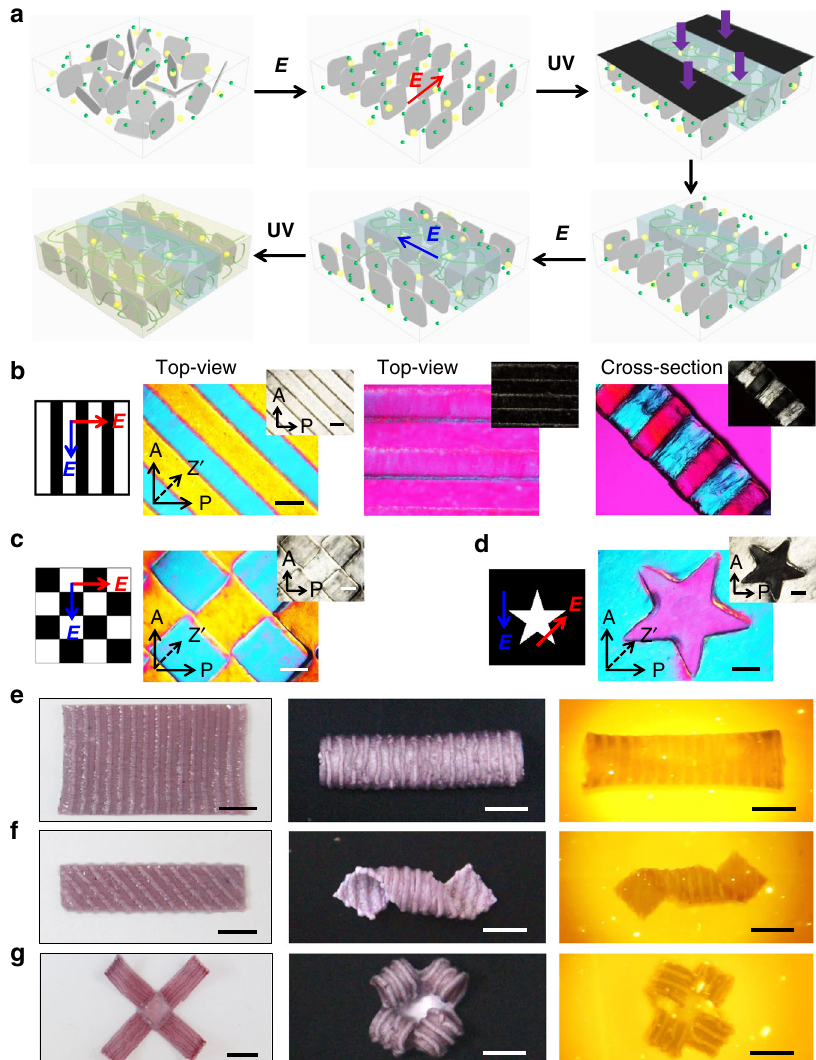
Fig. 3 Multi-step fabrication and programmed deformation of patterned anisotropic hydrogels. a – d Schematic for the preparation of patterned anisotropic hydrogel containing AuNPs by multi-step electrical orientation and photolithographic polymerization ( a ) and POM images of representative hydrogels patterned with different masks and alignment of NSs ( b – d ). Scale bar, 1 mm. e – g Photos of patterned anisotropic hydrogels before (the left column) and after the actuation of shape changing by incubating in a 40 °C water bath (the middle column) or by remote light irradiation (the right column). A cut-off fi lter is equipped on the camera to fi lter out the strong green light for better visualization of the hydrogel under the light irradiation. Scale bar, 5